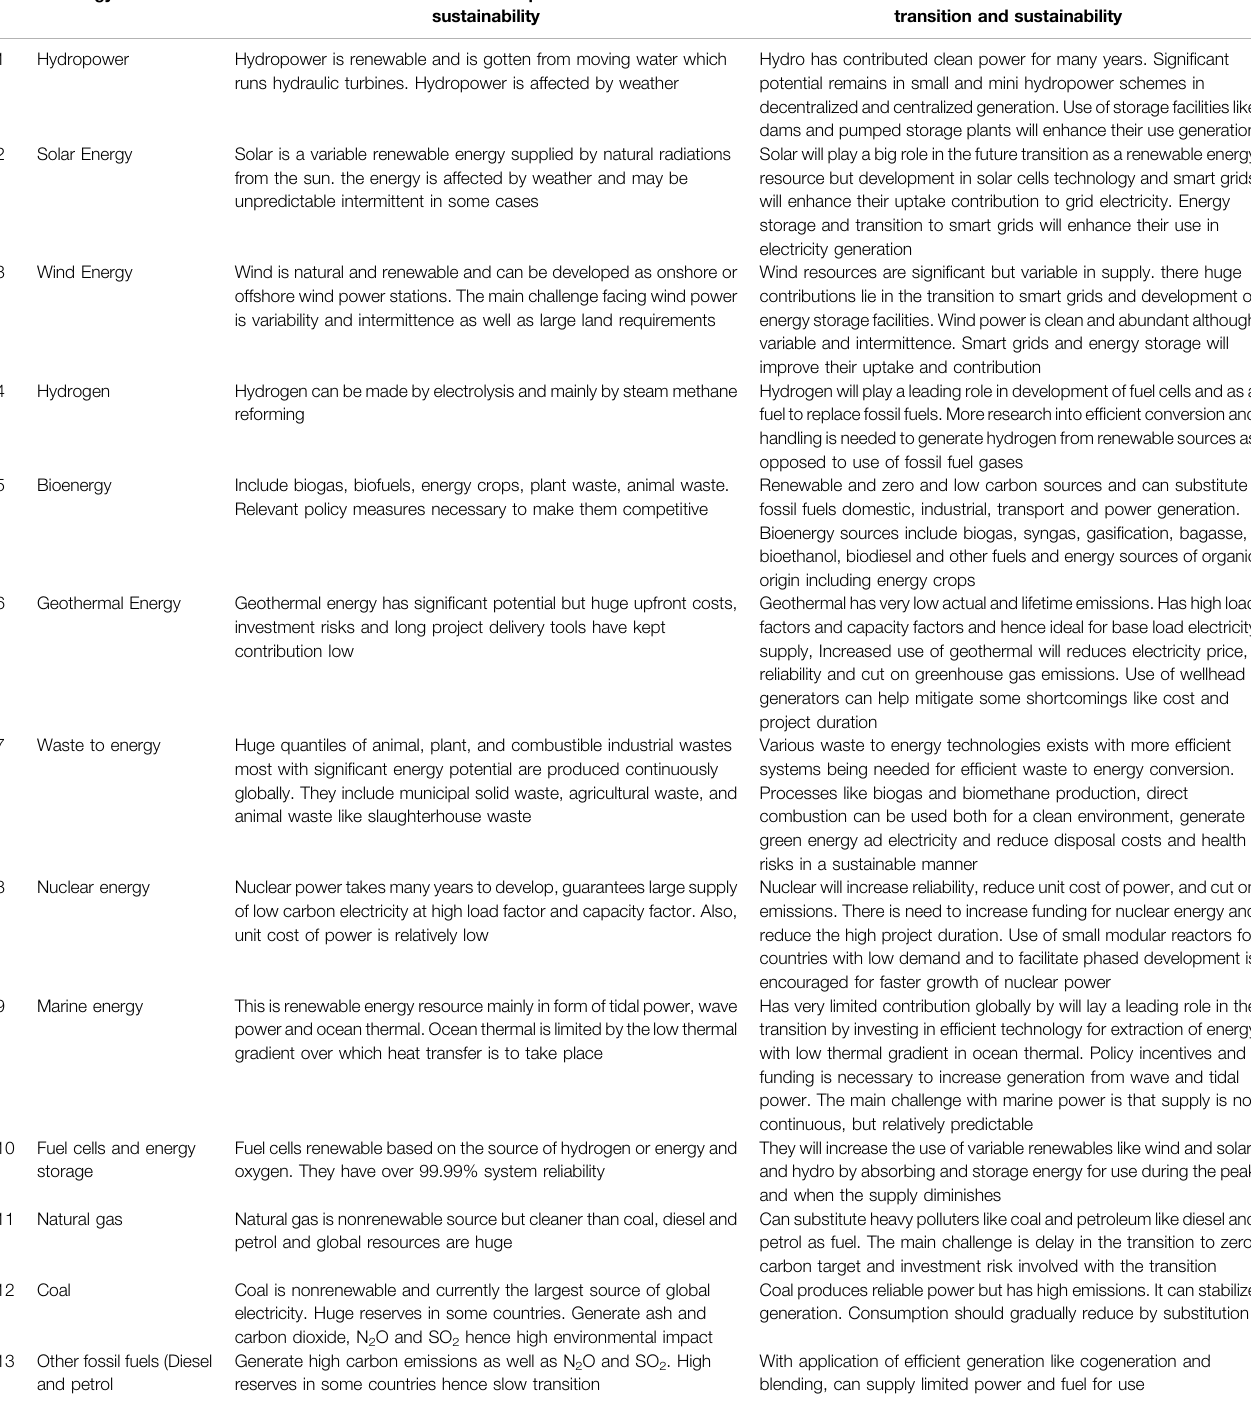
TABLE 5 | Summary of energy options for the global transition. Energy resource Features and composition